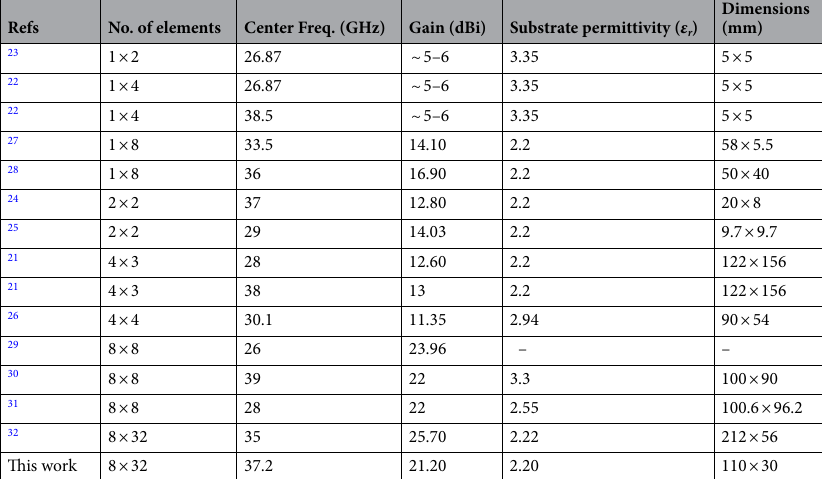
Table 4. Comparison of the proposed antenna array with recent